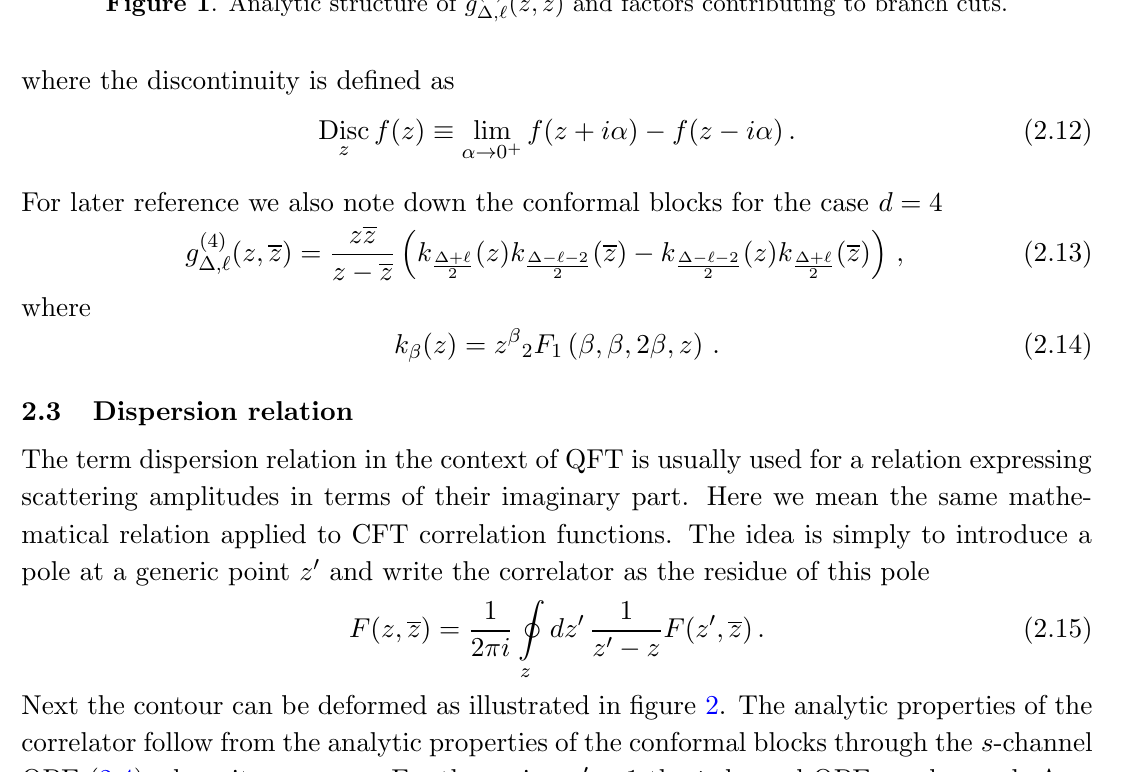
Figure 1 . Analytic structure of g ( d )